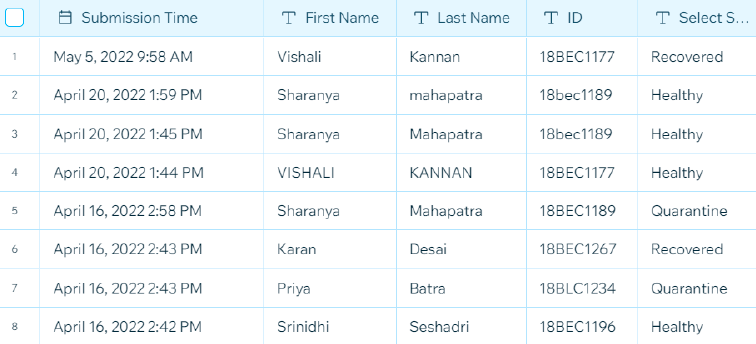
Figure A7. Overall status update track record .